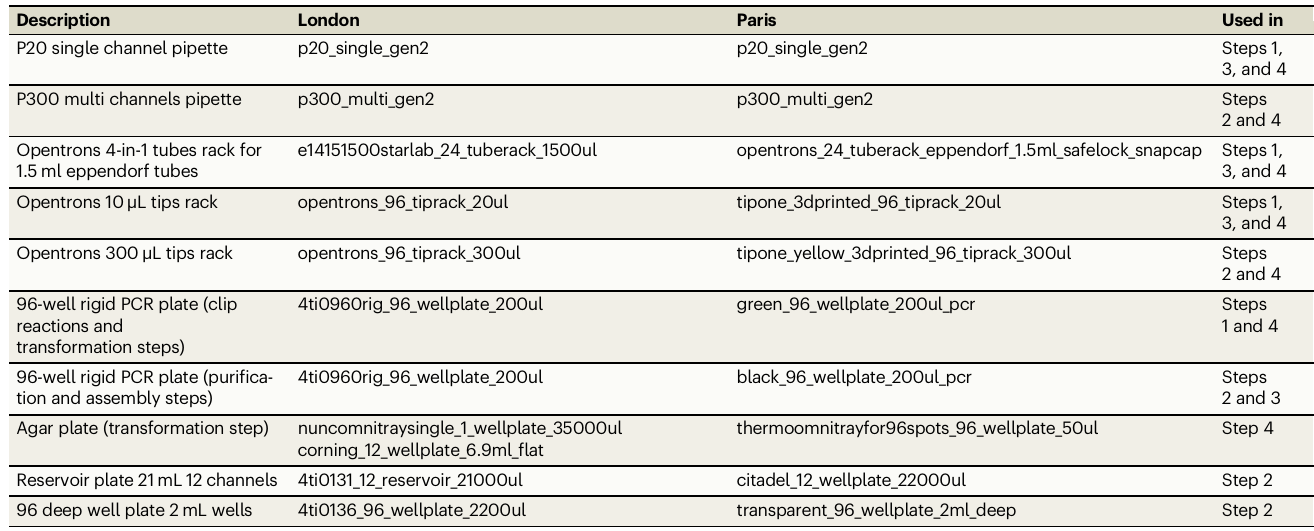
Table 1 | Labware IDs used at Imperial College (London) and Micalis Institute (Paris) laboratories Description